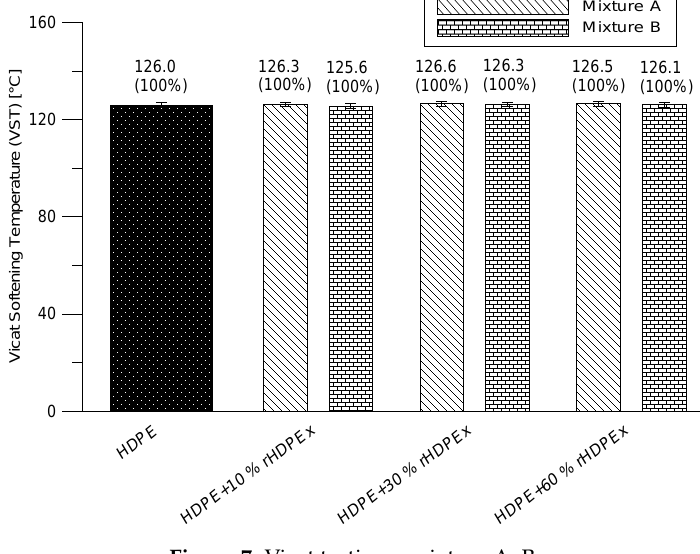
Figure 7. Vicat testing—mixture A,